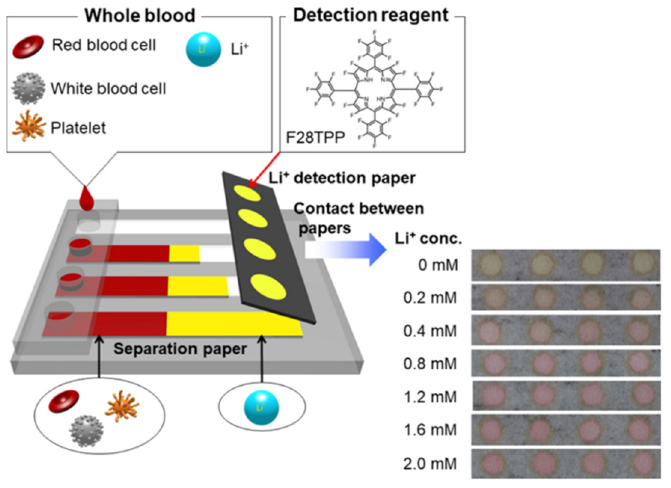
Figure 5. Paper-based device for colorimetric determination of lithium ions in human whole blood (modified with permission from Komatsu et al., ACS Sensors , 2020 [46]).